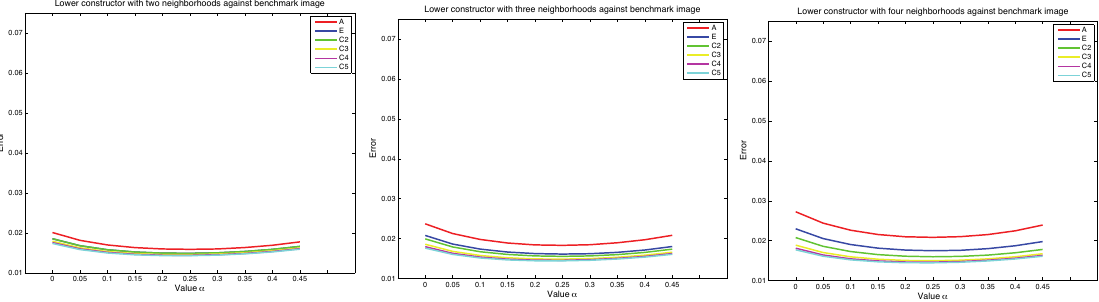
Figure 7: Performance of the lower constructor when 2 (left), 3 (middle) or 4 (right) neighborhoods are consid-